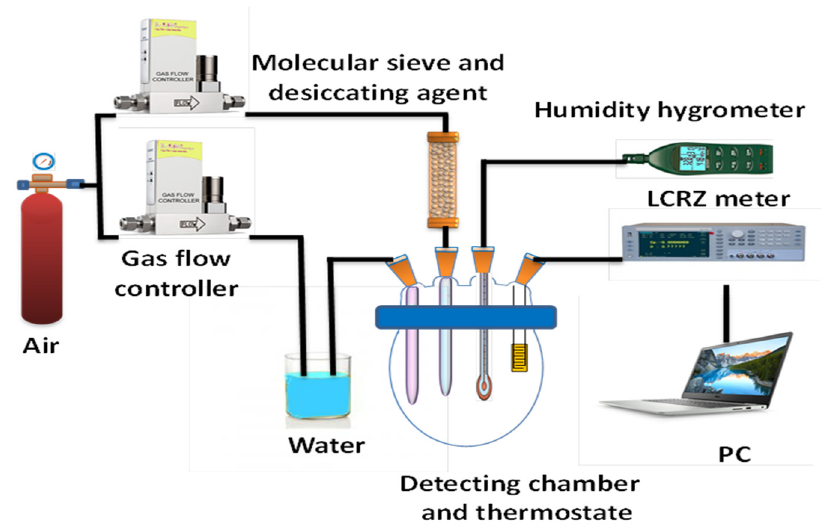
Figure 1. Schematic diagram of the experimental setup.